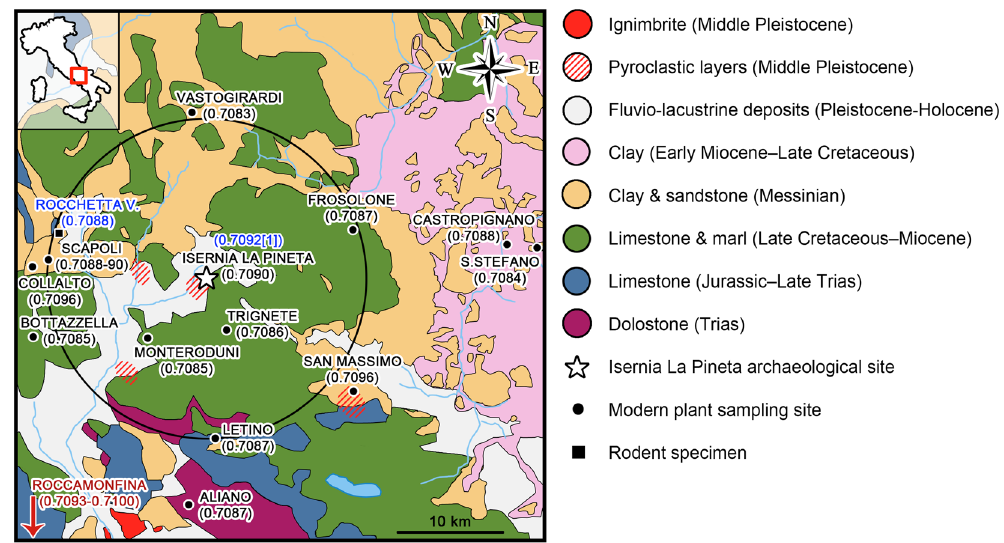
Figure 2. Simplified geological map of the Isernia area 39 with location of the sampling sites. Black numbers in parenthesis are 87 Sr/ 86 Sr ratios of modern plant specimens; blue 87 Sr/ 86 Sr ratios are rodent tooth specimens (data from Rocchetta a Volturno and local rodents from Isernia La Pineta), red 87 Sr/ 86 Sr ratios are Roccamonfina (~10 km southward) leucites 13 . Pyroclastic layers (oblique red lines) are documented in several localities by 18 . Black circle represents an area of 15 km surrounding Isernia La Pineta. Drawing by Federico Lugli (INKSCAPE 0.92,